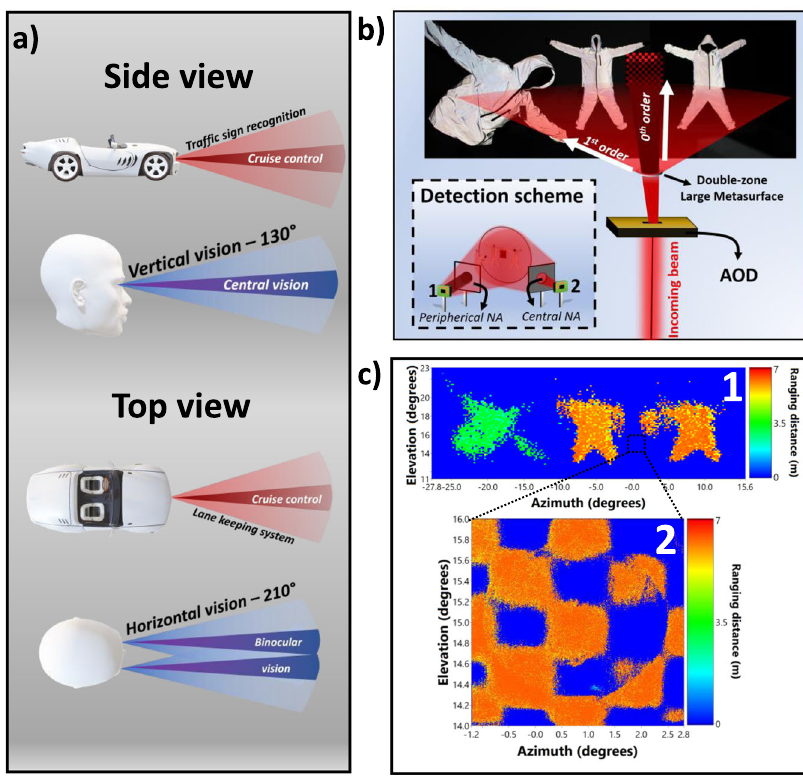
Fig. 4 | Multizone imaging. a Schematic representation of a human multizone viewing with the concept to be adapted in ADAS systems. Such mimicking char- acteristics enables double vision for dual-purpose imaging features for high-reso- lution, long range, in the center and lower resolution, bigger FoV, for the peripherical view. b Experimental realization to test the dual-zone imaging func- tionality of the LIDAR system, including dual detection scheme (inset) for simul- taneousimagemultiplexedcollection.Thecentral0thdiffractionorderbeamscans